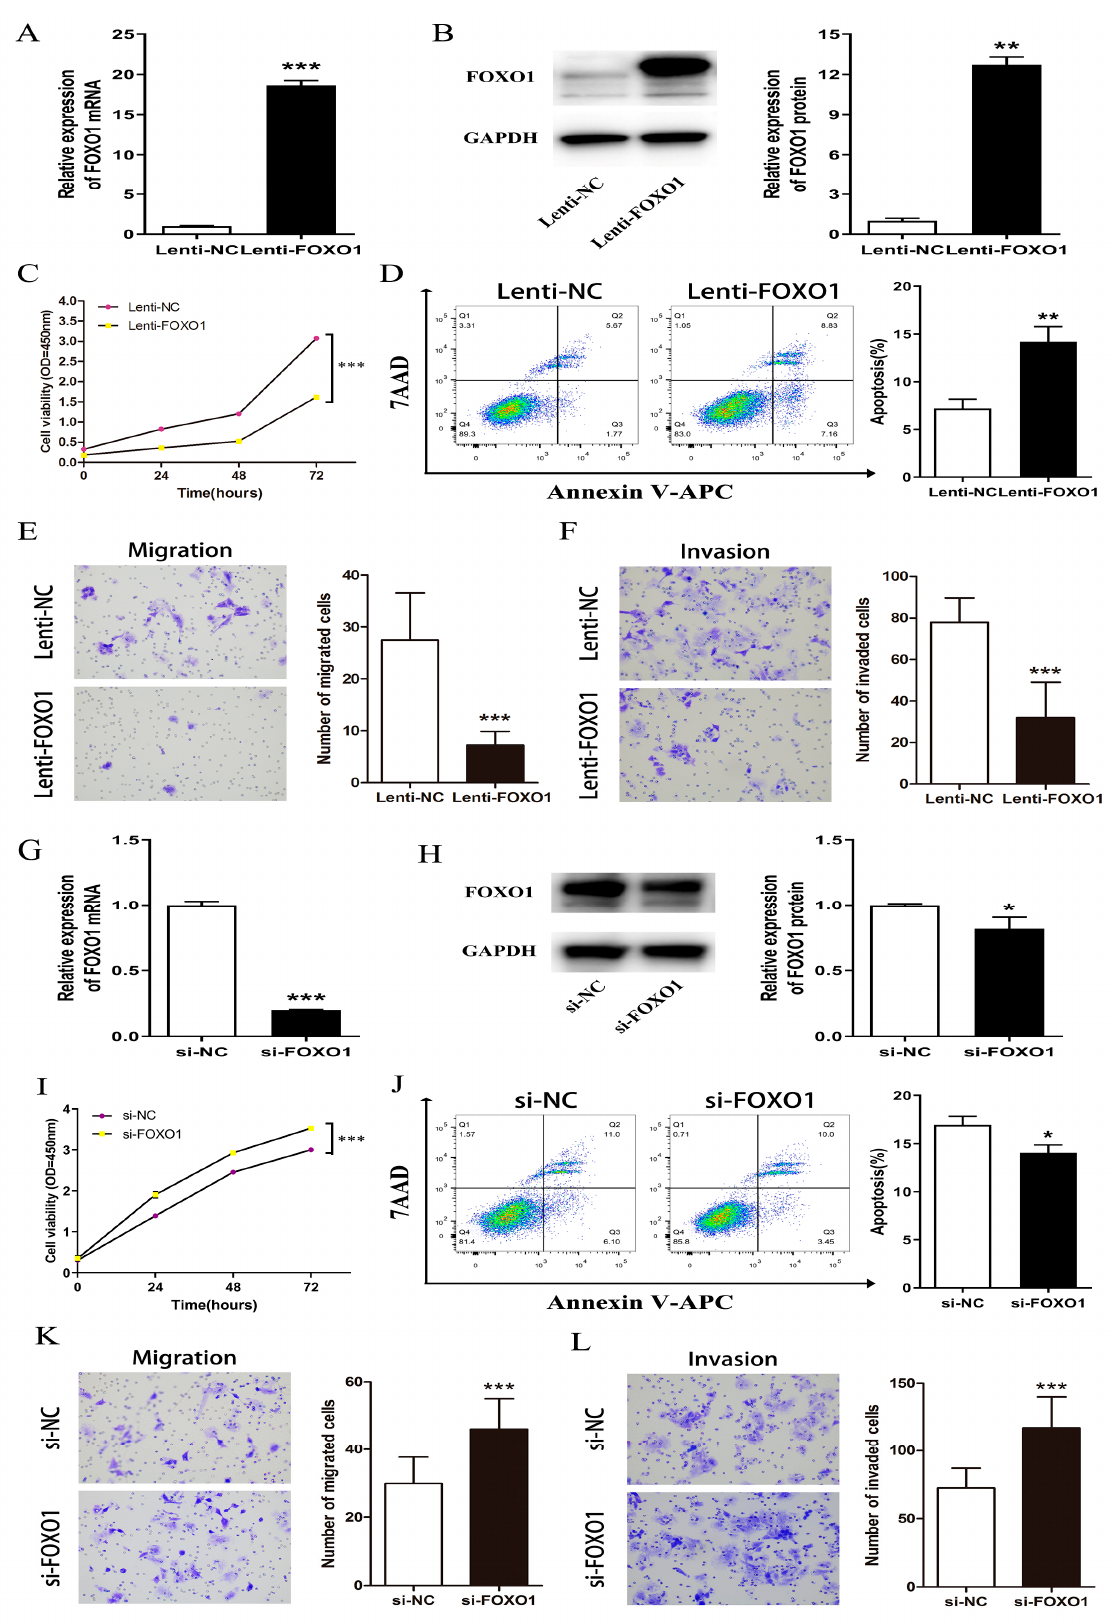
Figure 8. ( A , B ) QRT-PCR and western blot showed that expression of FOXO1 mRNA and protein were significantly upregulated in HepG2 cells transfected with overexpressed vector. ( C )